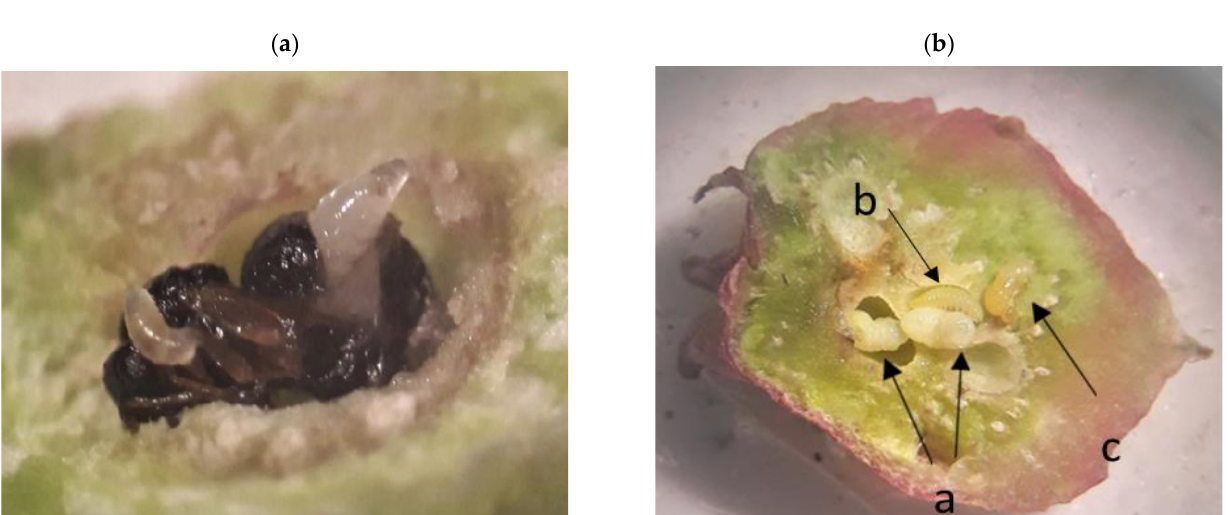
Figure 6. ( a ) Confirmation of the presence of parasitoids with a spring gall showing D. kuriphilus pupa parasitized by two parasitoid larvae; and ( b ) the natural parasitism of D. kuriphilus with a dissected spring gall where (a) two parasitized D. kuriphilus larvae; (b) parasitoid larvae; (c) parasitoid pupa.